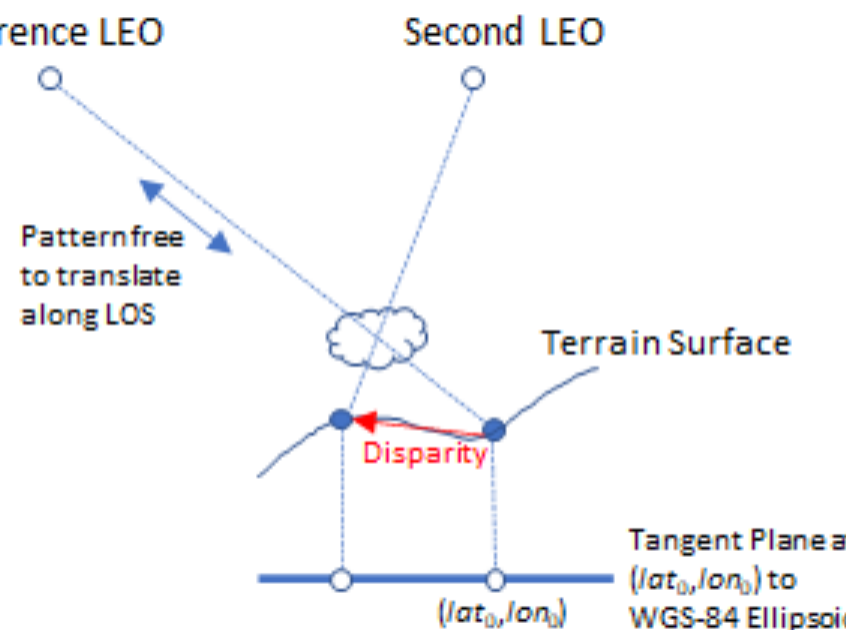
Figure 1. The retrieved wind 3D location is anchored to the apparent horizontal coordinates of the tracked feature or pattern ( lat 0 , lon 0 ) but free to translate along the Line-of-Sight (LOS) of the reference satellite. The retrieved height and horizontal wind vector are jointly retrieved to minimize the sum of the squared differences between observed and modeled disparities after including a third observation of the feature. The knowledge of pixel times is important for modeling the disparities as the correct combination of feature parallax and velocity.